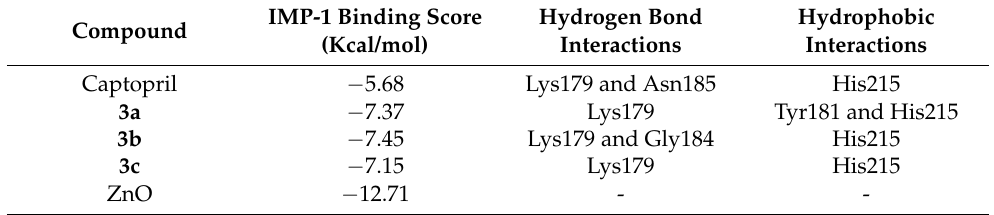
Table 1. Binding scores and binding interactions of the investigated compounds with IMP-1 active